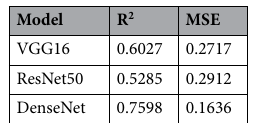
Table 1. The model performance of VGG, ResNet, and DenseNet